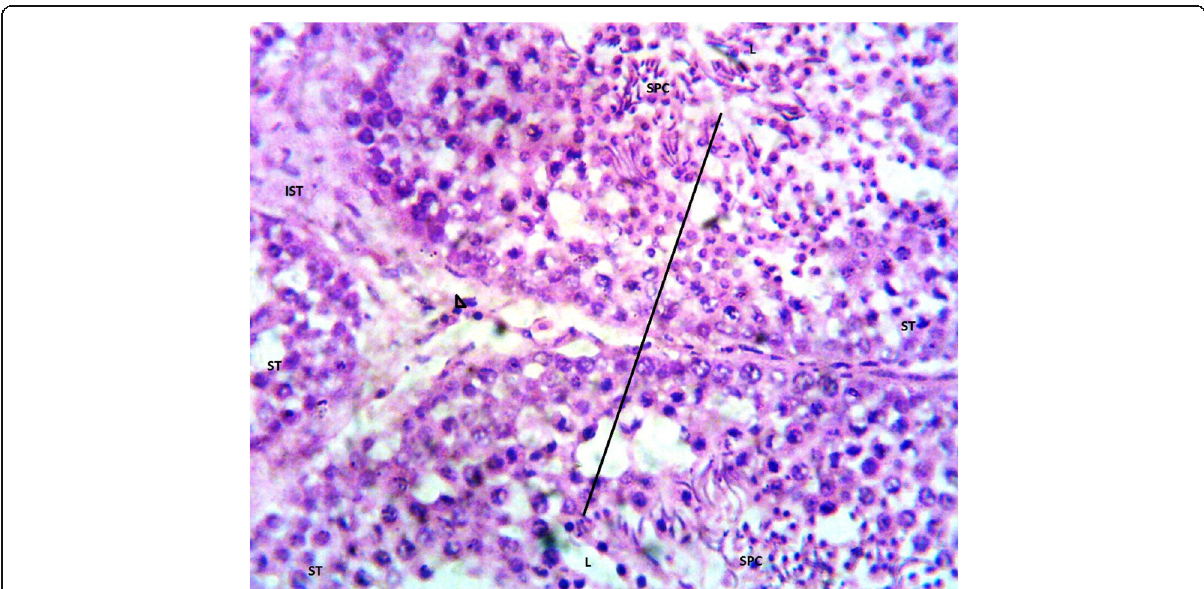
Fig. 7 Representative micrograph of testis section (× 400) of broiler chicks fed 0.0% PCM supplemented diet. This section shows the testicular tissue composed of coils of seminiferous tubules (ST). The ST contains germinal epithelium with germ cells at varying degree of maturity (line). The interstitium (IST) is free of collection and contained interstitial cells of Leydig (arrowhead)